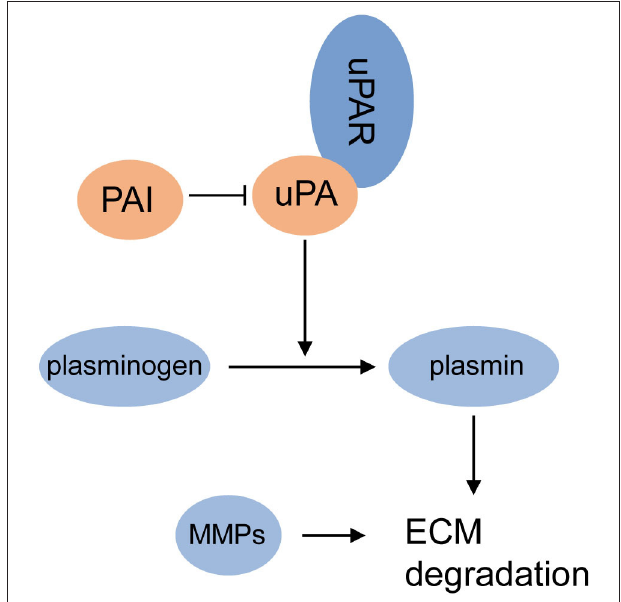
FIGURE 3 | uPA system and MMPs promote ECM degradation. uPA is recruited by uPAR and is negatively regulated by PAI1 or PAI2; overproduction of uPA increases the transformation from plasminogen to plasmin; plasmin promotes the degradation of ECM surrounding the tumor with MMPs, and promotes the initiation of invasion and